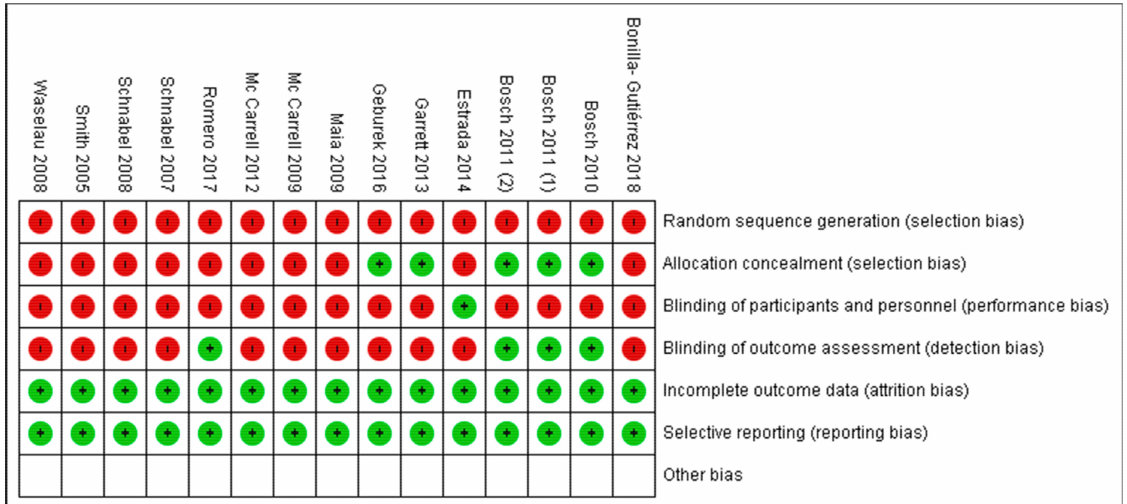
Figure 5. Summary of risk of